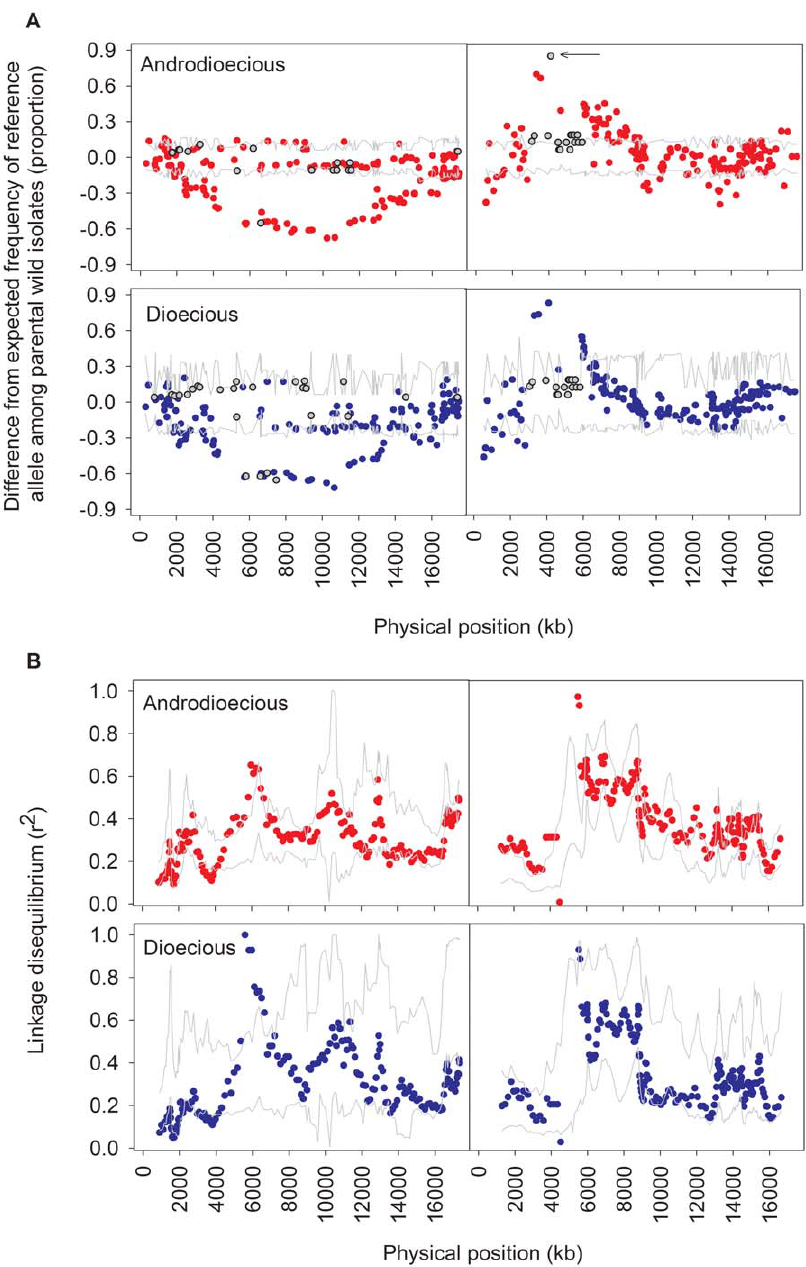
Figure 1. Observed SNP allele frequencies in ancestral populations. In A is represented the SNP frequency difference from the expected frequency among parental wild isolates of a reference allele (N2 wild strain) relative to physical position for chromosome IV (left panels), or chromosome X (right panels). Top panels show observed SNP allele frequencies in the ancestral androdioecious population (red). Bottom plots represent observed frequencies in the dioecious population (blue). Gray lines indicate the 95% of simulated data expected under random sampling during the derivation (see Materials and Methods ). Gray circles represent SNPs that were lost during the derivation, as measured by a minor allele frequency of , 0.026 in either population. The arrow indicates the SNP upon which a selective sweep of the wild isolate N2 allele is modeled during the androdioecious derivation. In B , linkage disequilibrium among pair-wise SNPs is shown in 10 SNP-wide windows with overlapping step sizes of 1 SNP. Values are plotted at the mean physical position of the SNPs present in each window. Gray lines indicate the 95% of simulations